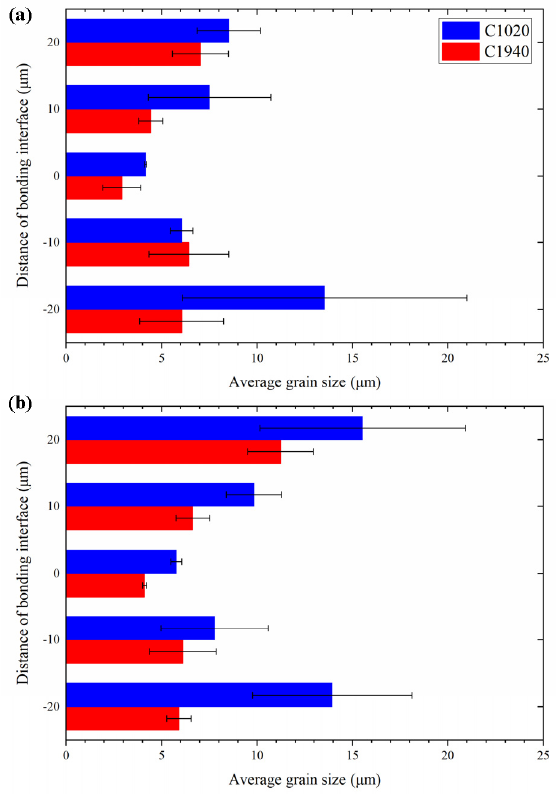
Figure 9. Average grain size of C1020 joints and C1940 joints ( a ) before and ( b ) after the thermal cycling test.